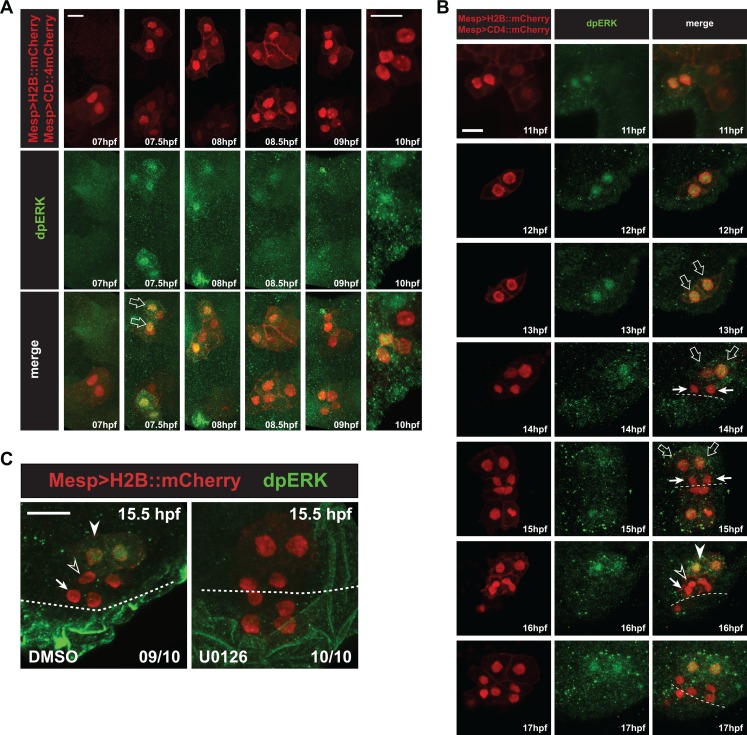
Detailed patterns of MAPK activity during early cardiopharyngeal development.(A) MAPK activation during TVC induction. Close-up views of B7.5 lineage cells marked with Mesp > H2B::mCherry (nuclei) and Mesp > hCD4::mCherry (membranes) and immunostained for dpERK at indicated successive time points between 7 and 10hpf. DpERK staining was not detected in the founder cells at 7hpf, but increased sharply and specifically in the smaller trunk ventral cells (TVCs, open arrows) at 7.5hpf, but not in the larger anterior tail muscles (ATMs). DpERK staining persisted throughout TVC migration (see also B). (B) MAPK activation patterns during cardiopharyngeal fate diversification. DpERK staining was clearly detected in migrating TVCs (open arrows, 11 to 13hpf); in lateral large STVCs (open arrows, 14 to 15hpf), but not in the small median first heart precursors (FHPs, arrows, 14 to 15hpf); in the large lateral atrial siphon muscle founder cells (ASMFs, solid arrowheads, 16 to 17hpf), but neither in the FHPs (arrows), nor in the second heart precursors (SHPs, open arrowheads). (C) Treatment with the MEK inhibitor U0126 from 12 to 15.5hpf abolished dpERK staining in the lateral STVCs, compared to a control treatment with DMSO. Numbers of embryos showing the presented pattern out of the total numbers of embryos are shown.